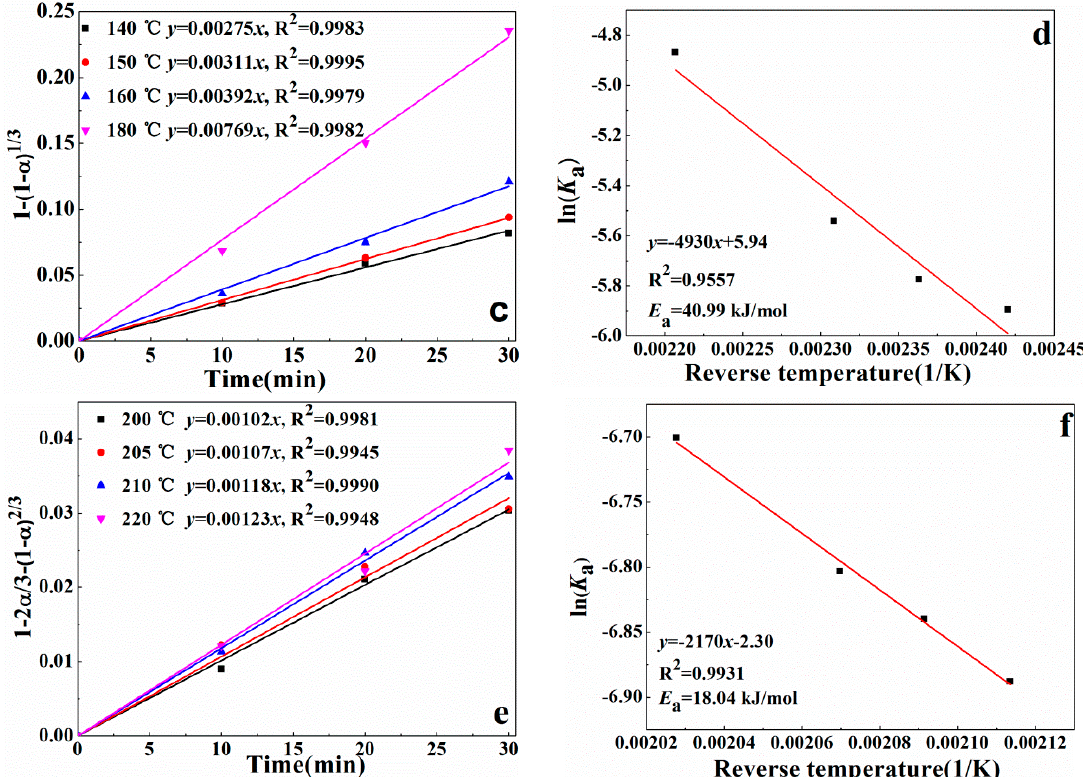
α (1 − α ) 2 / 3 ] versus time for CaO, ( b ) ln( K a ) versus 3 α − (1 − α ) 2/3 ] versus time for CaO, ( b ) ln( K a ) versus 3 α − (1 − α ) 2 / 3 ] versus time for 3 α − (1 − α ) 2/3 ] versus 3